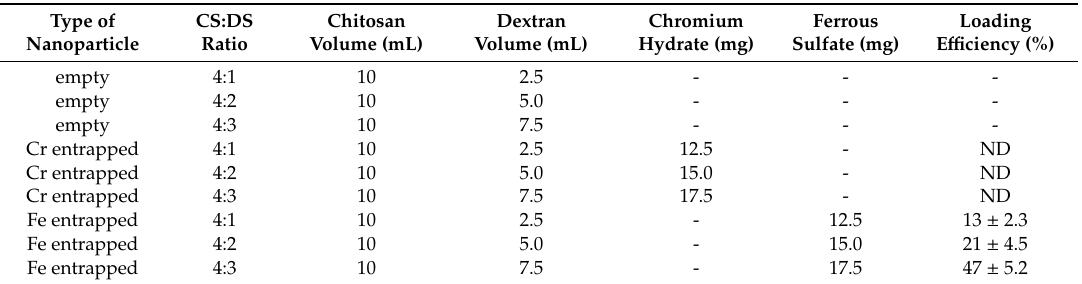
Table 1. Composition of chitosan–dextran sulfate (CS-DS) nanoparticle formulations (not determined (ND)). Type of